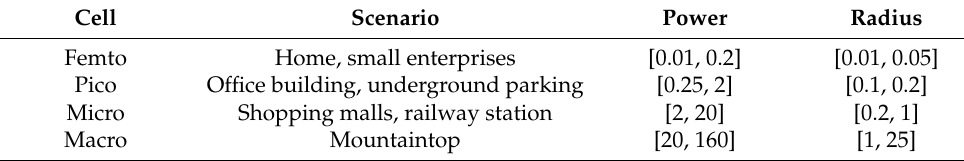
Table 1. A comparison of several network types